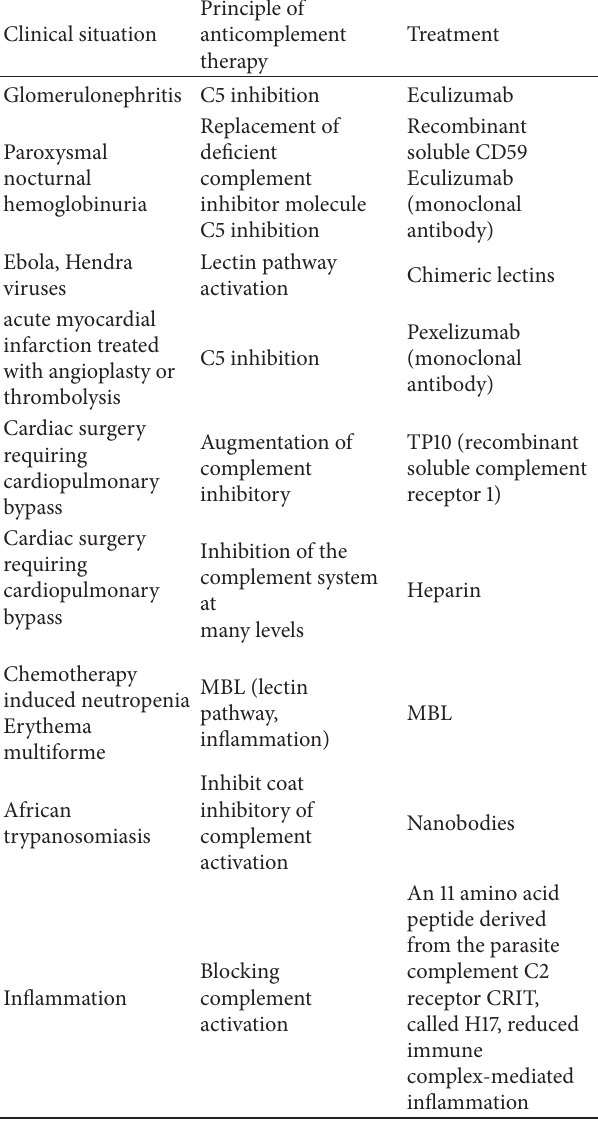
Table 1: Clinical complications associated with complement defi- ciencies. A clear decrease at the serum levels or complete absence of complement factors or complement regulatory proteins alter the different complement pathways.Several clinical complications are summarized including the complement pathway involved, the defi- cient complement factor and the clinical manifestation